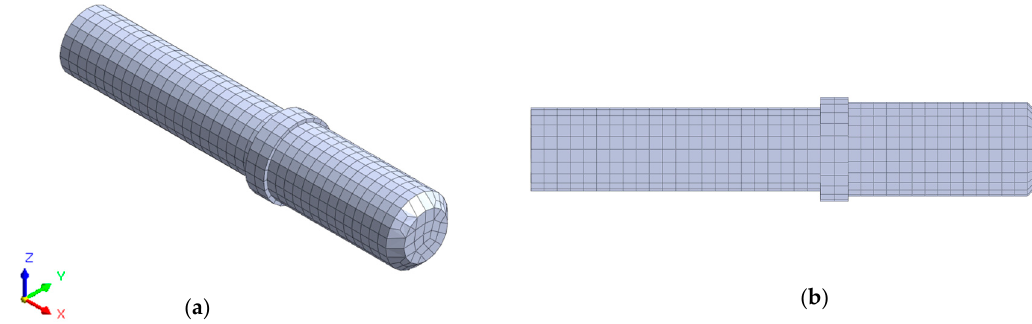
Figure 11. Discretized model of analyzed shaft, ( a ) isometric view and ( b ) cross-sectional view.